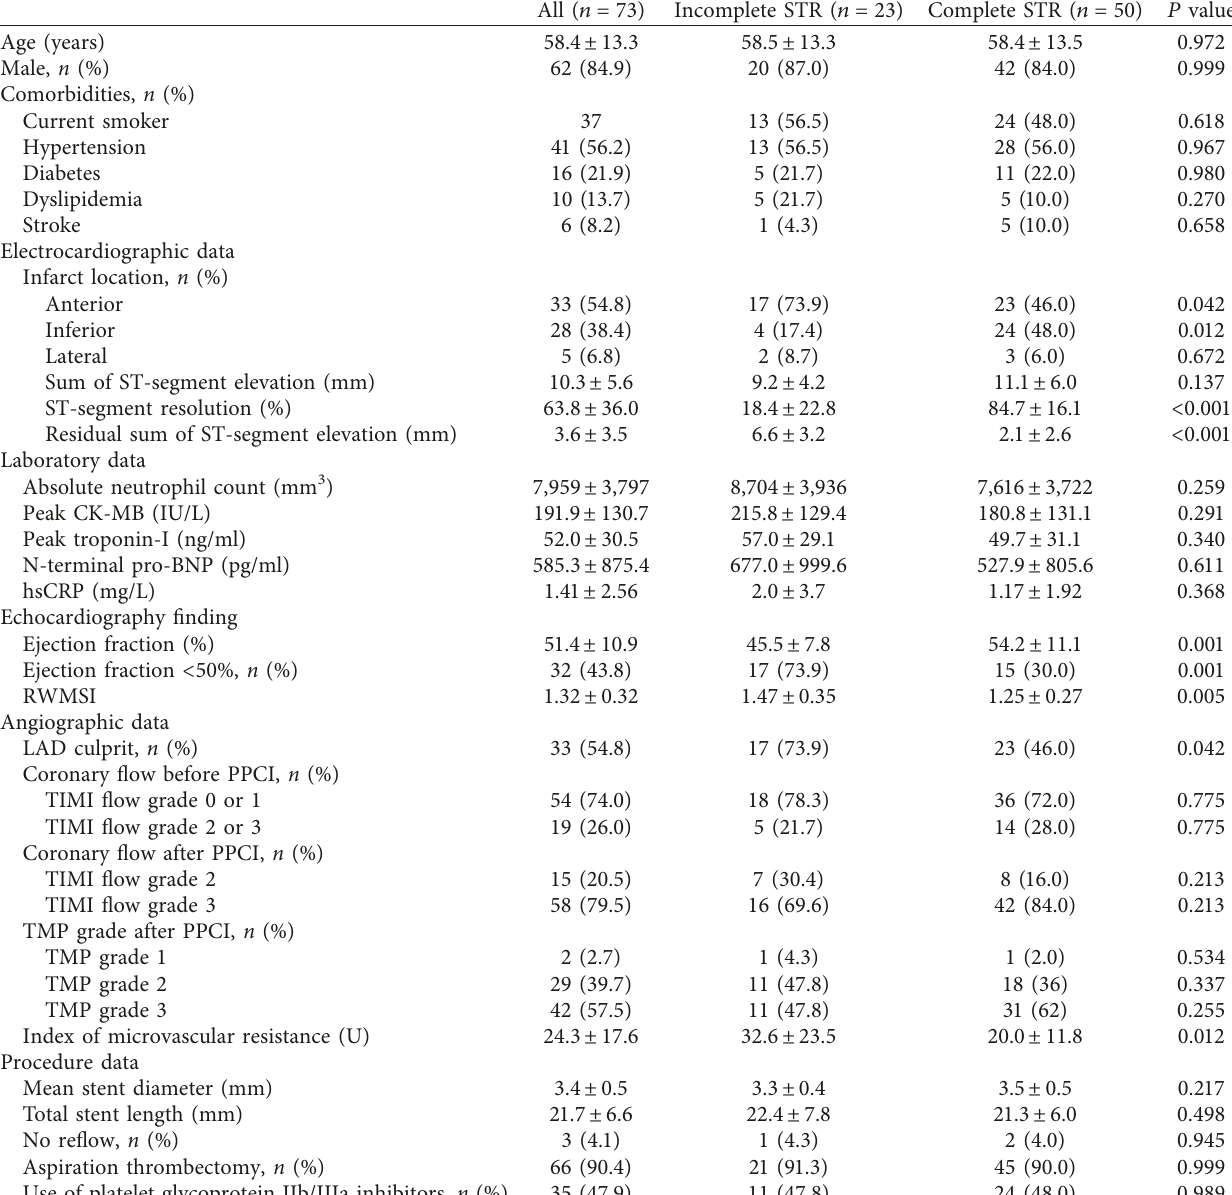
Table 1: Baseline, angiographic, and procedural